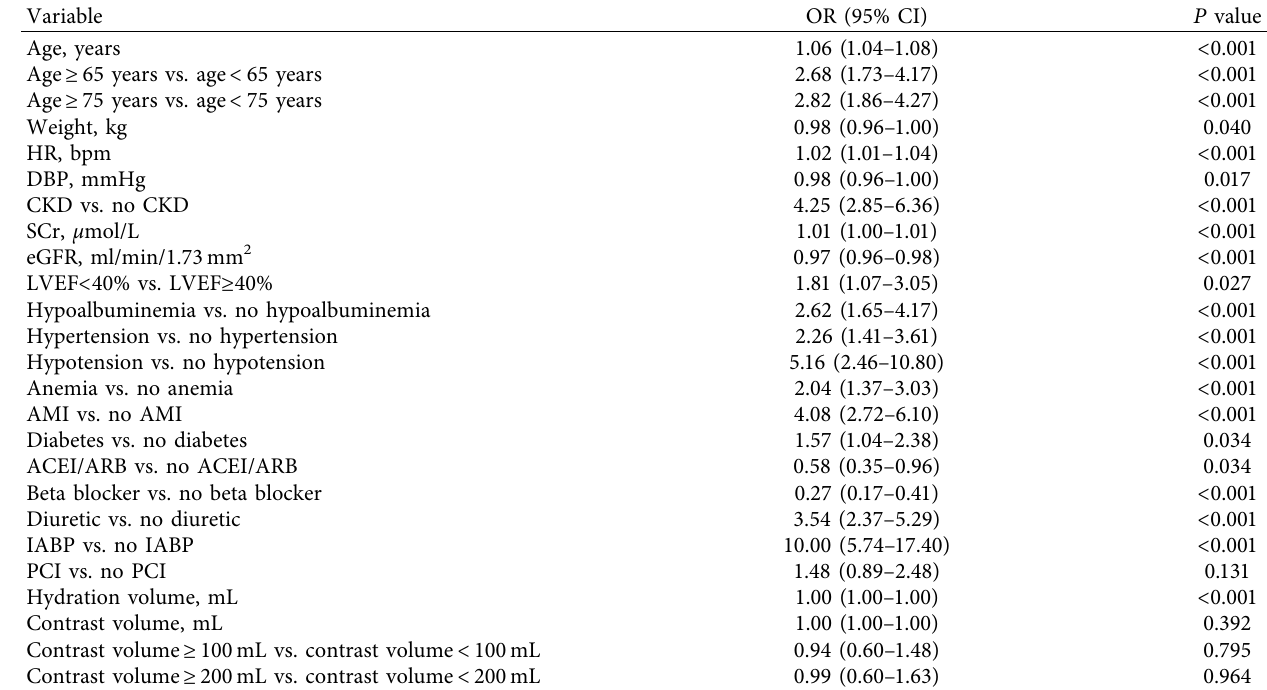
Table 2: Univariable logistic regression analysis of CI-AKI.